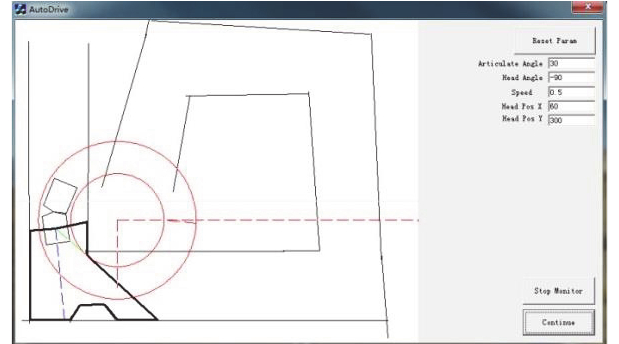
Figure 8: Simulation software